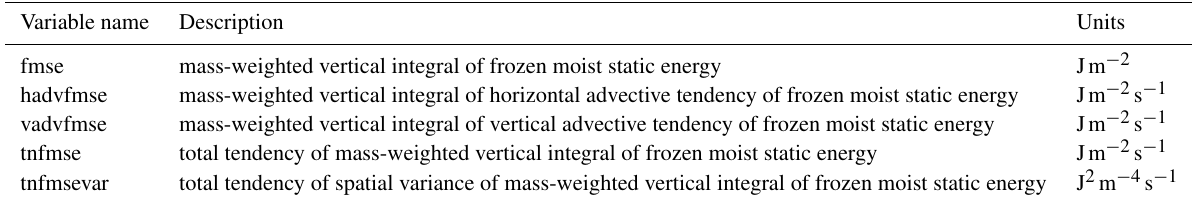
Table 6. The 2-D instantaneous hourly variables ( x,y,t ). Variable name